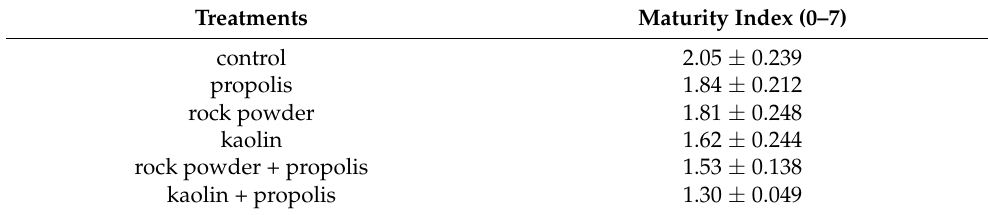
Table 1. Effect of treatments on maturity index of olives of the cultivar Borgiona (all mean ± SE). No differences were detected among treatments according to linear model followed by multiple comparisons